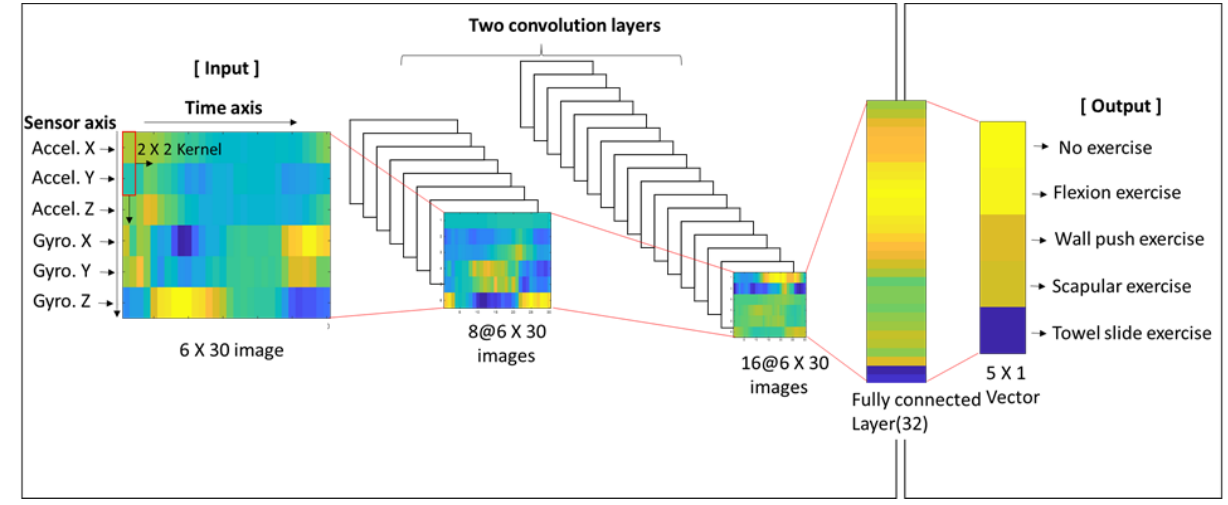
Figure 3. Baseline convolutional neural network architecture.